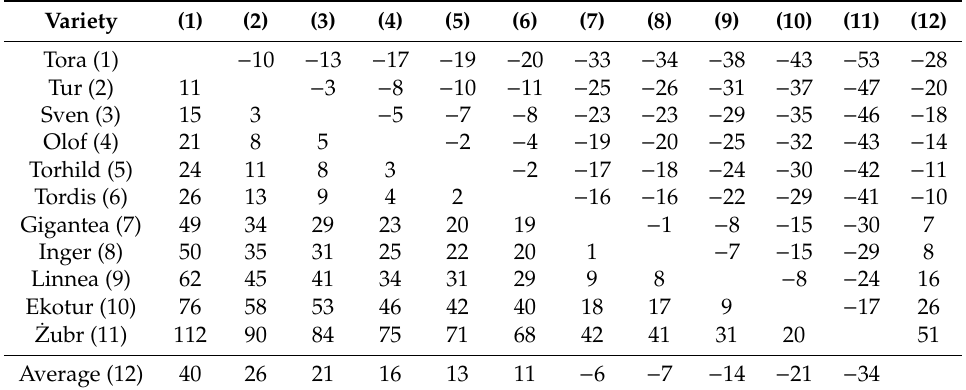
Table 2. Matrix of di ff erences (%) between yields of dry mass of tested varieties of willow.